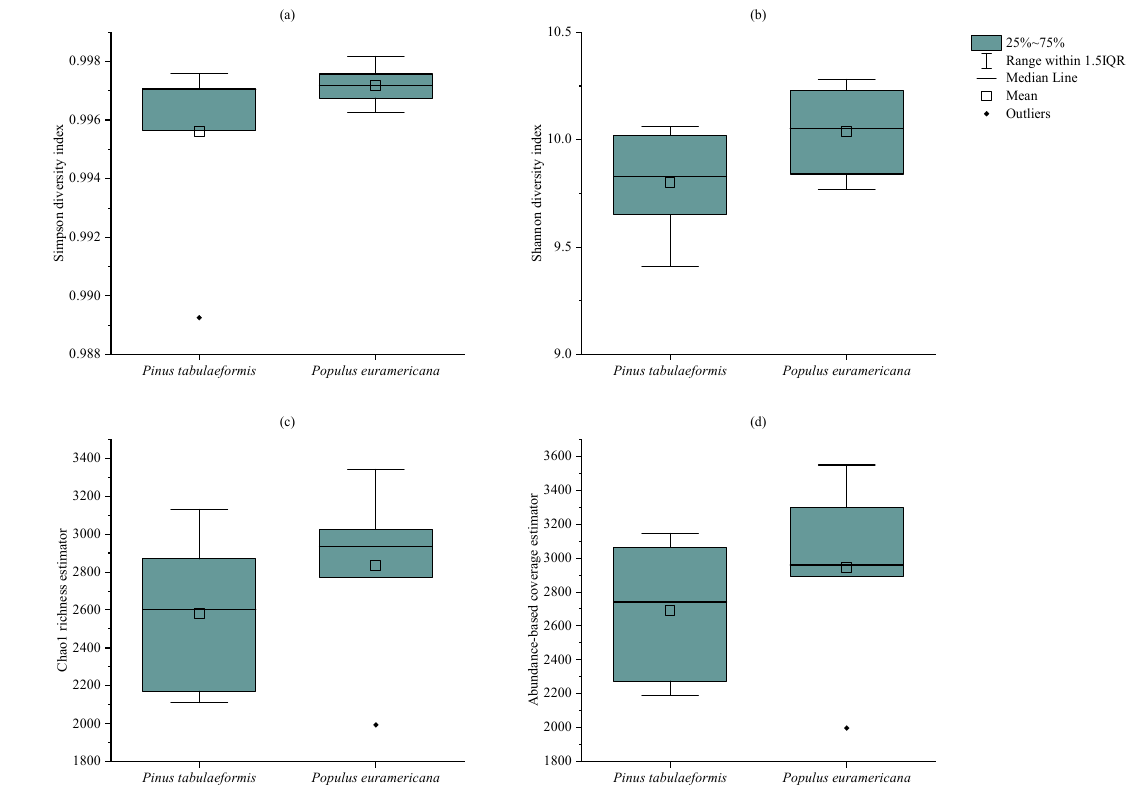
Figure 4. Alpha diversity index of each sample under the reclamation of P. tabulaeformis and P. euramericana. ( a ) is Simpason diversity index, ( b ) is Shannon diversity index, ( c ) is Chao 1 richness estimator, ( d ) is Abundance based coverage estimator.